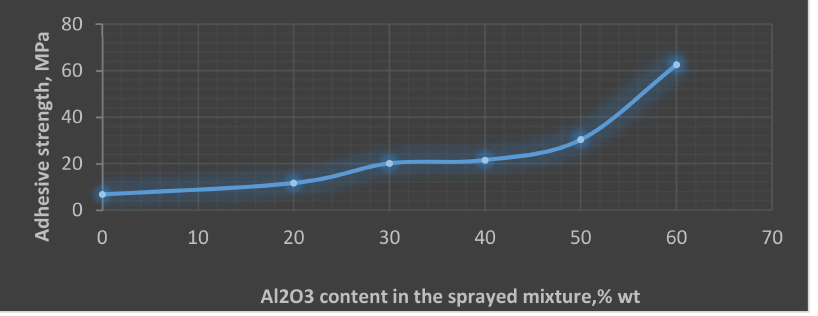
Figure 6. The relation between adhesion and Al 2 O 3 content in the two-component powder system Cu-Al 2 O 3